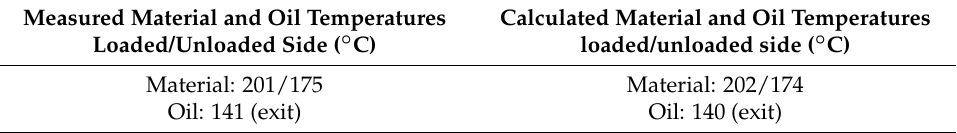
Figure 17. On the LHS, a cut through the outer ring and the hub shows the interface to the squeeze film damper, the oil passages and the location of the highest load (contact area). On the RHS, the two planes are in a certain depth into the material. There, thermocouples (3 from each side) were recording the outer ring temperatures. The temperature levels correspond to the operating condition at 20,000 rpm, 80 kN axial load, 480 L/h lubricant oil flow, and 120 L/h outer ring cooling flow. Table 4. Comparison between the measured and the calculated average temperatures for the Outer ring at the operating conditions mentioned